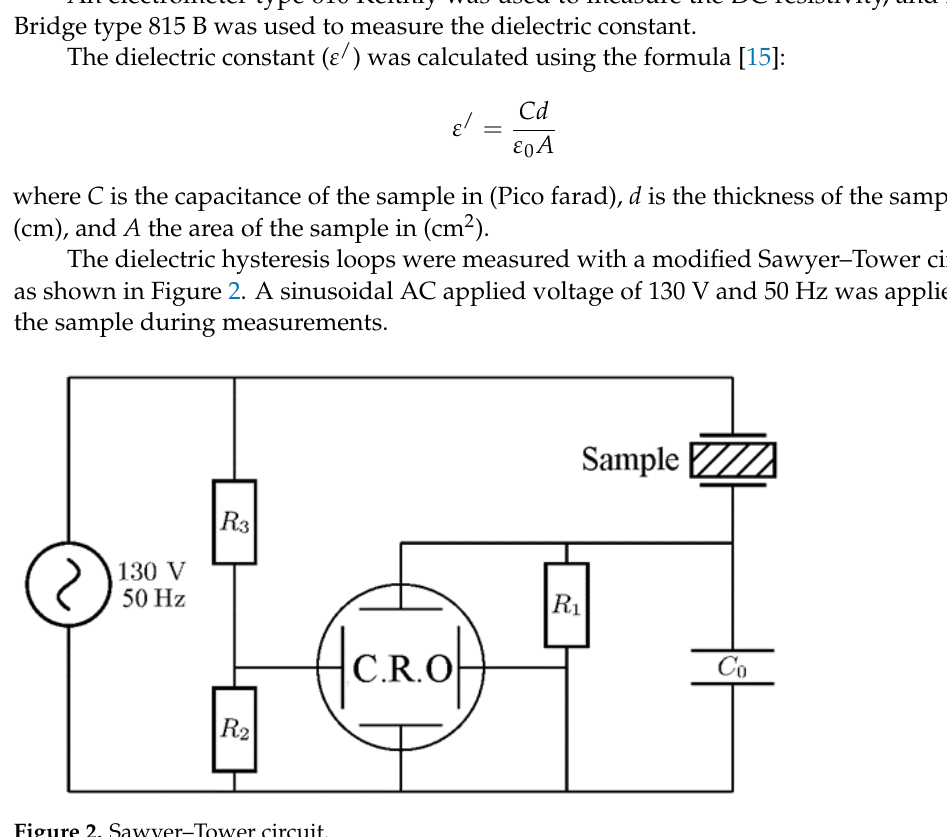
Figure 3. The XRD patterns of the prepared (BZT-PVDF) composite.